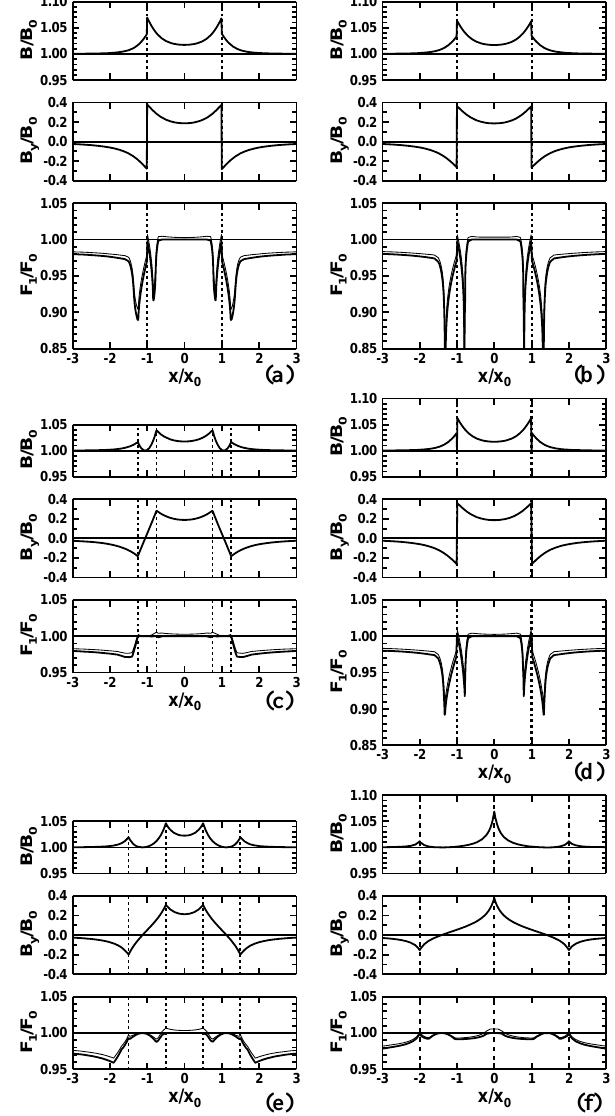
Figure 8. Magnetic field and particle flux variations near the sheets. B is the magnetic field magnitude, B y is the field component gen- erated by the sheets, and F 1 is the hemispheric particle flux. Details are given in the